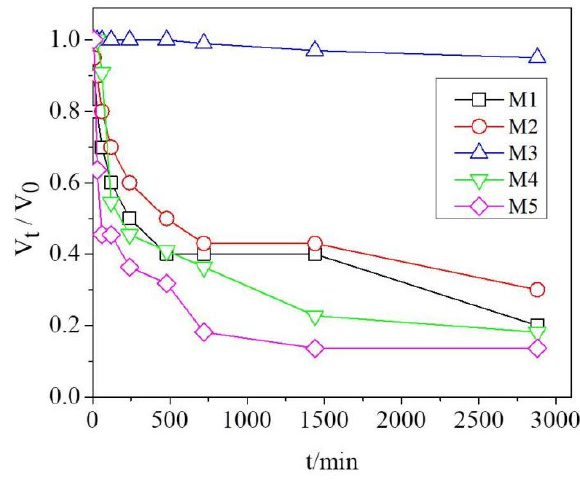
Figure 5. The change of V t /V 0 (shrinkage degree) of P(OEGMA-co-MEO 2 MA) hydrogels formed from microgels as a function of time.